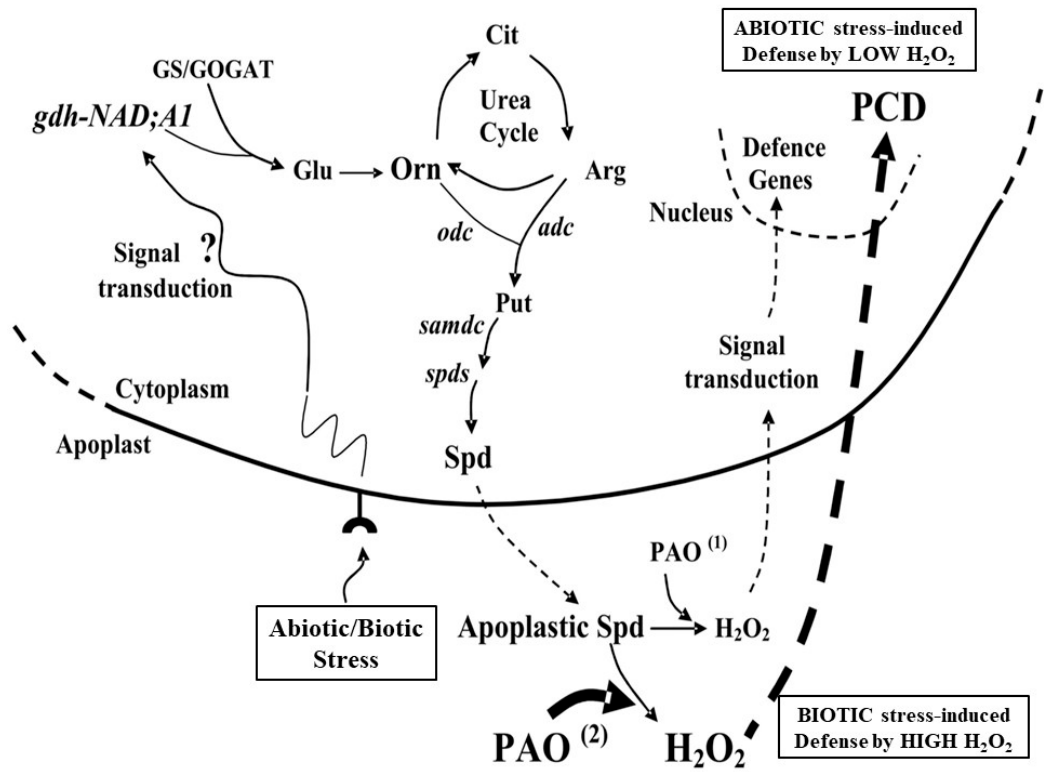
Figure 1. Proposed model for the nitrogen–polyamine (N-PA) interplay in plant abiotic / biotic stress signaling and defense. Abiotic or biotic stress induces proteases activity and increases in ammonium ions inside the cell. The reactive oxygen species (ROS) stress signal triggers the induction of the gene encoding the α -subunit of glutamate dehydrogenase (gdh-NAD; A1), which contributes, together with the GS / GOGAT cycle, to ammonia assimilation [34,41]. Stress-induced glutamate (Glu) production by GDH is diverted to Pro biosynthesis. Stressful conditions cause a further increase in endocellular PAs that are excreted and apoplastically oxidized by polyamine oxidase (PAOs), thus, producing H 2 O 2 and numerous N composites. Depending on the level of H 2 O 2 produced under abiotic stresses, programmed cell death (PCD; high H 2 O 2 levels above a certain threshold) or H 2 O 2 scavenging (low levels below a certain threshold) is activated [22,27,28,33]. However, the biotic stress-induced H 2 O 2 causes a reverse pattern, as high H 2 O 2 levels form an apoplastic “barrier” protecting the plant from fungi and bacteria [30]. Ascorbate peroxidase (APX) and other antioxidant genes are also involved during the protection response. Moreover, PAs are peroxisomally back-converted to generate H 2 O 2 and N compounds that could activate Ca 2 + permeable channels [2,22,28,32,73,97]. PAO (1) : Decrease of PAO activity results in increased Spd and Spm contents and low levels of H 2 O 2 , leading to expression of defense genes and plant tolerance to abiotic stress, but susceptibility to biotic stress (fungi and bacteria); PAO (2) : Increase of PAO activity results in lower Spd and Spm contents and high levels of H 2 O 2 , leading to abiotic stress-induced PCD accompanied by plant abiotic stress susceptibility, but tolerance to biotic stress due to high levels of H 2 O 2 , which form a “barrier” to fungi and bacteria. The other abbreviations are found in the text.